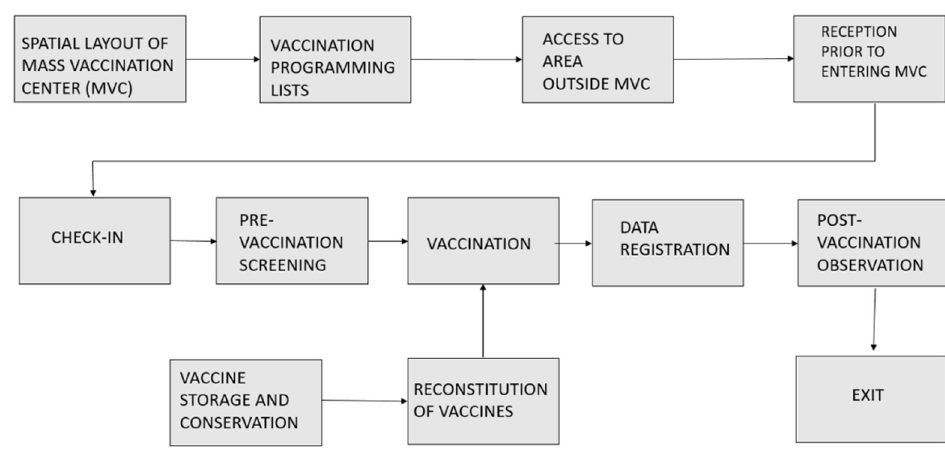
Figure 2. Phases of the mass vaccination process.